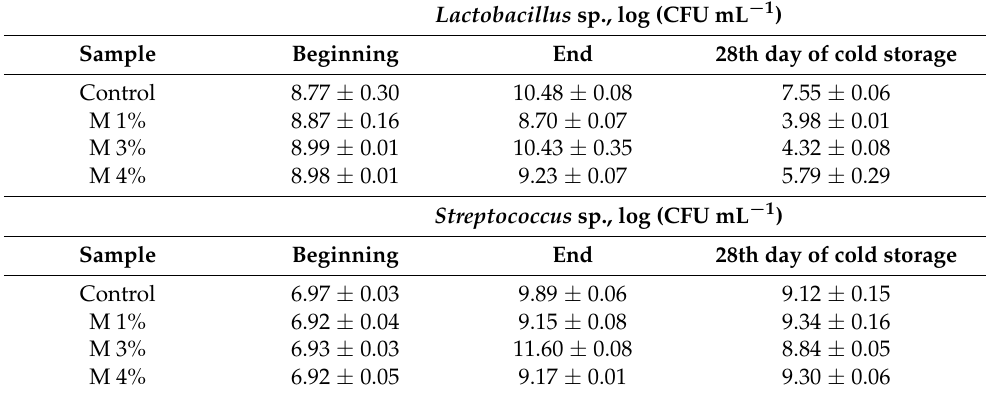
Table 3. Lactobacillus sp. and Streptococcus sp. counts in control sample (Control) and samples with moringa extract addition (1, 3 and 4% of extract addition, M 1%, M 3%, M 4%) at the beginning and end of fermentation and at the last day of cold storage (28th day) expressed as log CFU mL − 1 .